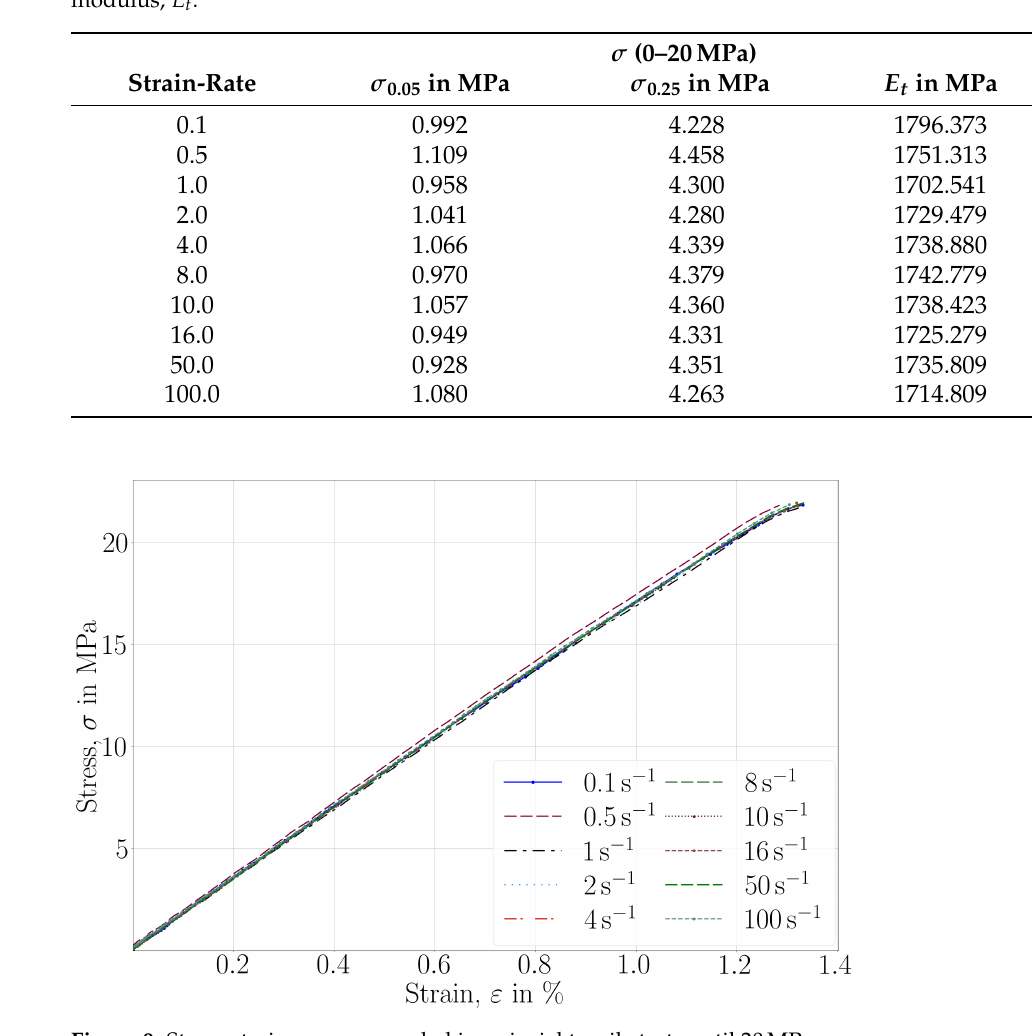
Table 7. Strain rate-dependency, uniaxial tensile test results, normal stress at two normal strain values, σ 0.05 = σ ( ε = 0.05% ) and σ 0.25 = σ ( ε = 0.25% ) , are used for determining the Young’s modulus, E t .